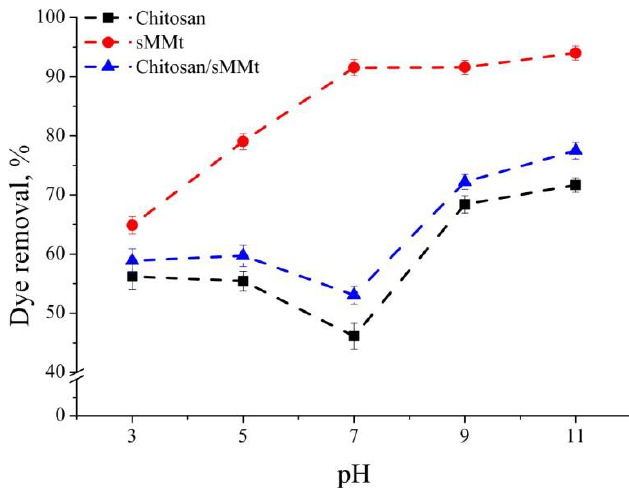
Fig. 7 Effect of pH toward methylene blue dye removal by chitosan, sMMt, and